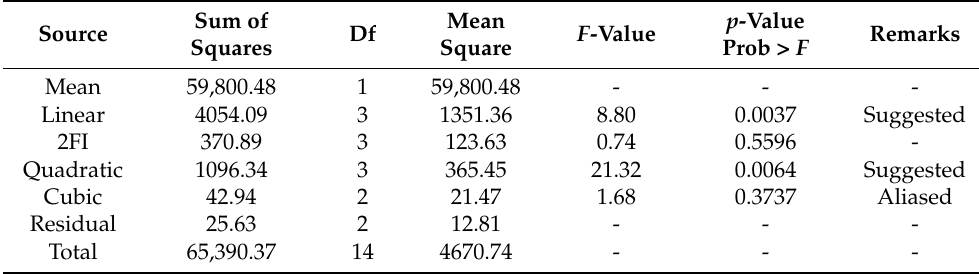
Table 3. Sum of squares in a subsequent